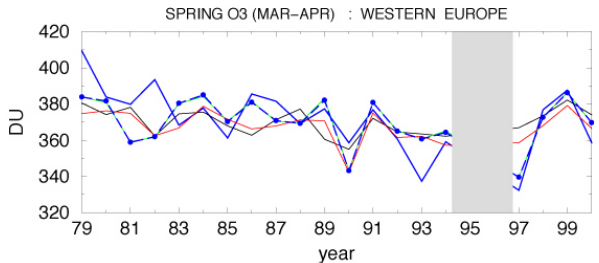
Fig. 5. Spring ozone over Western Europe (40 ◦ N–60 ◦ N, 15 ◦ W– 15 ◦ E) from TOMS data (thick blue line) for 1979 to 2000; recon- structed spring ozone with anomalies from the four leading Euro- Atlantic patterns successively added to the climatological mean: i.e. including the NAO (black), plus the Scandinavian pattern (red), plus the East-Atlantic pattern (green) and the European blocking pattern (thick blue dashed). The combined curve (thick blue dashed) best tracks the observed ozone variations (thick blue line), albeit the last pattern brings little change over that region (adapted from Orsolini and Doblas-Reyes,